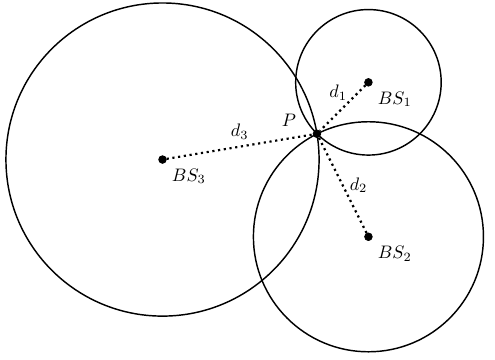
Figure 3. Range measurement based 2D positioning with at least 3 BS.